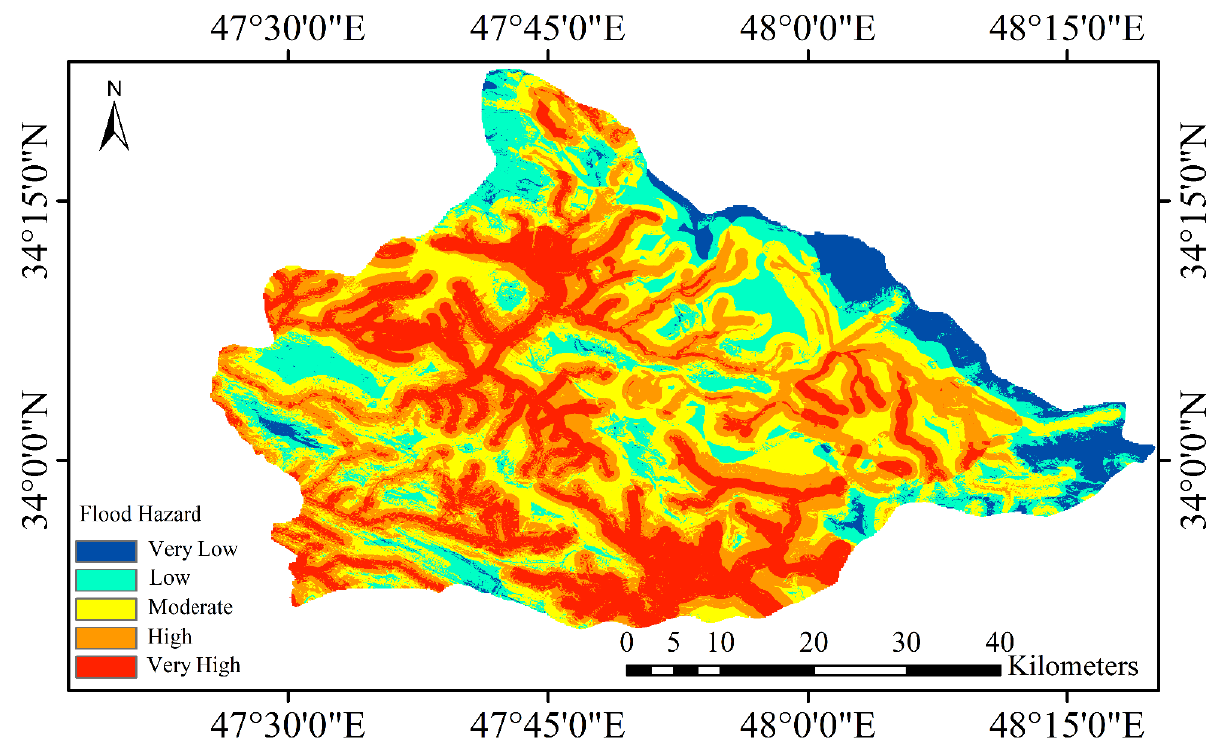
Figure 11. The produced flood hazard map in the Nurabad watershed using the proposed method.